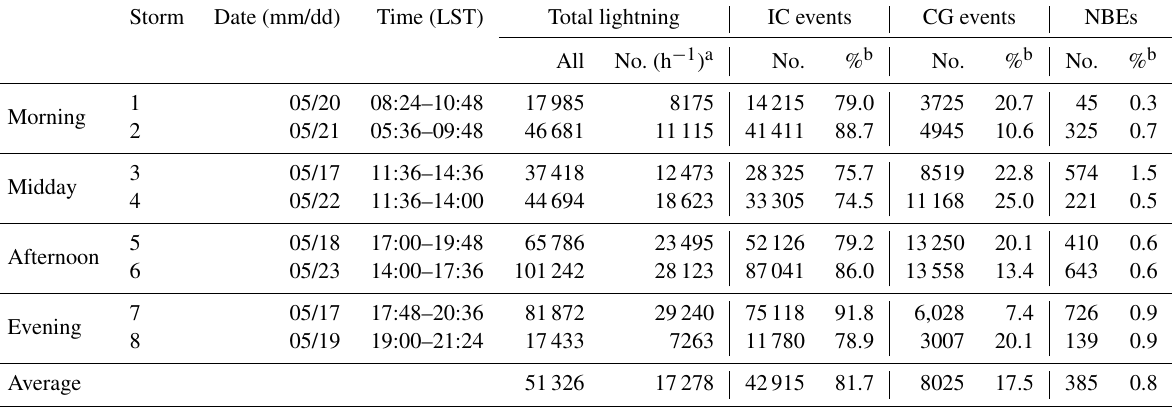
Table 2. Overall characteristics of eight thunderstorms occurring within a week.